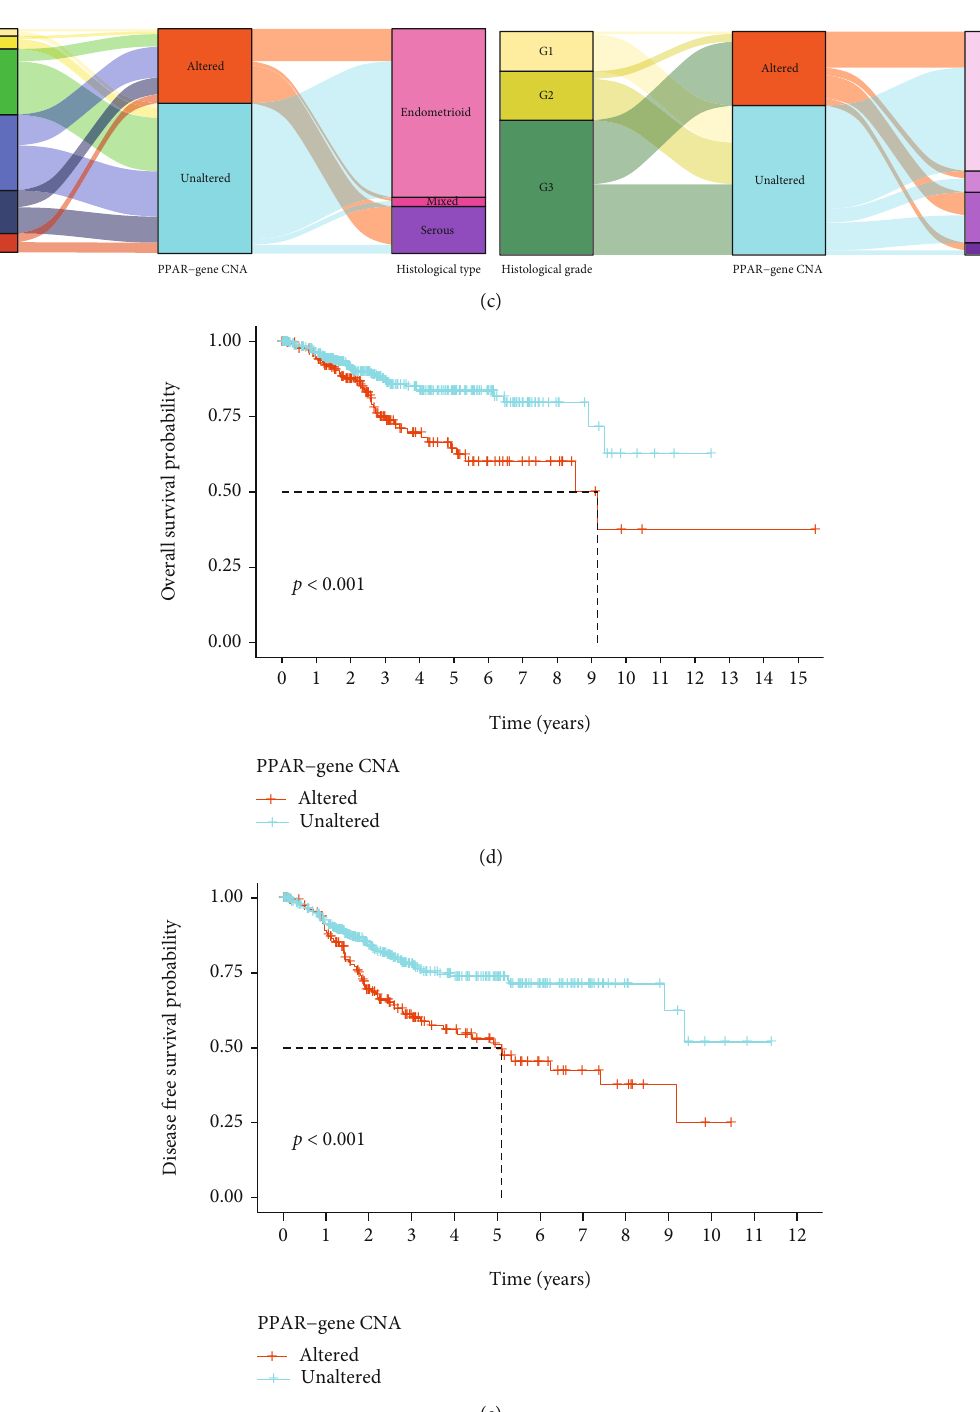
Figure 1: The CNA status of PPAR-related gene and related clinical features in UCEC patients. (a) The frequency of CNA alterations of PPAR-related gene in patients with di ff erent histological types. (b) The CNA type ratio of each PPAR-related gene. (c) Sankey plots show the clinical information of PPAR-related gene CNA and non-CNA patients. Kaplan-Meier curves show the correlation between PPAR-related gene CNA status and overall survival (d) or disease-free survival (e) probability of UCEC